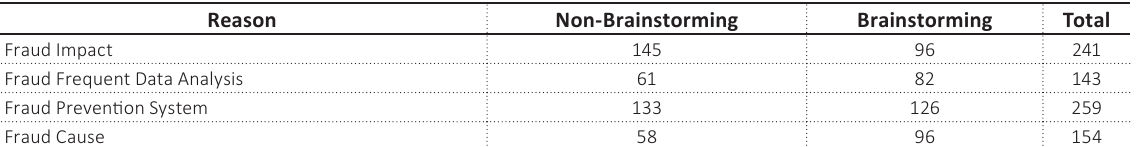
Table 5. Reasons for fraud risk assessment